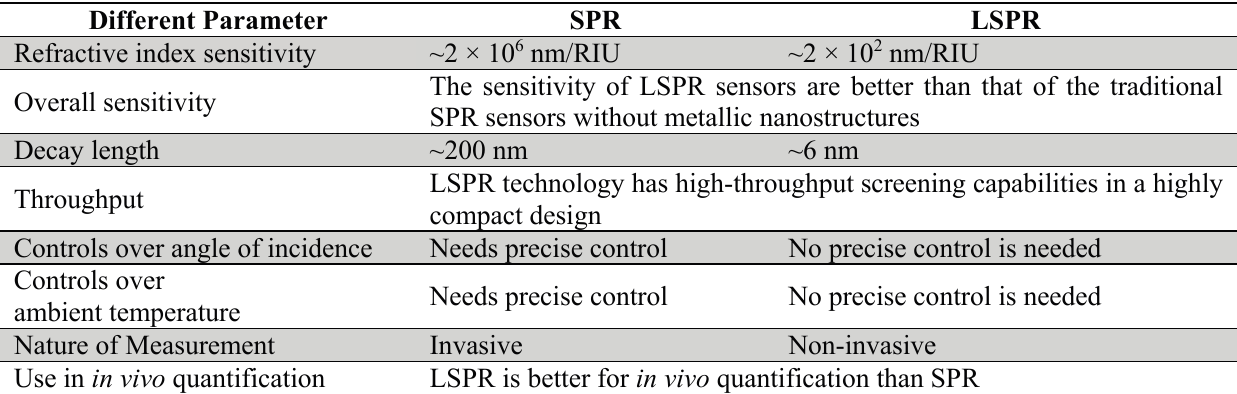
Table 10. Differences between SPR and LSPR sensors